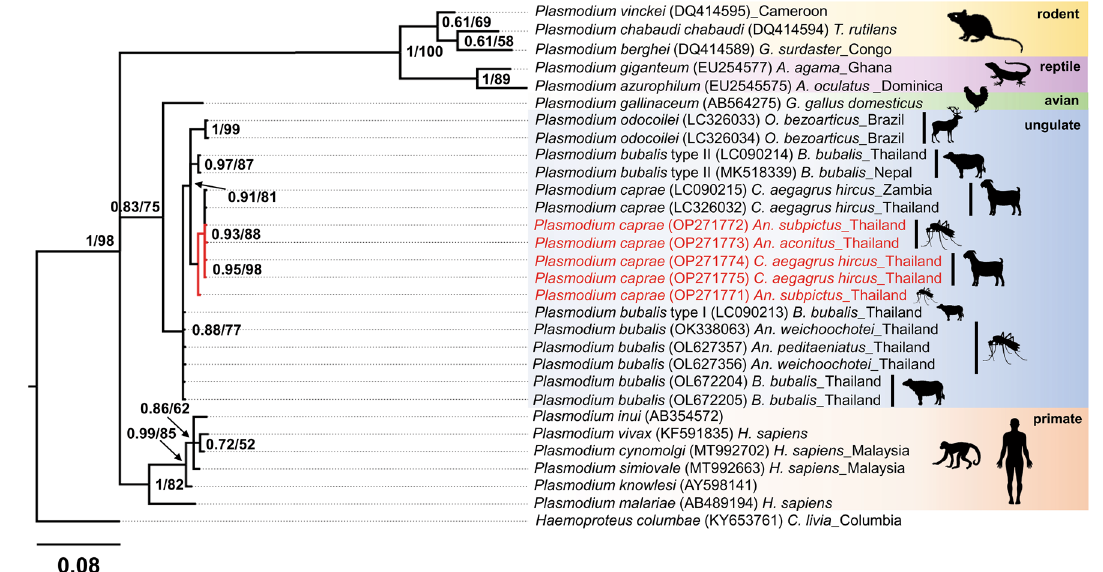
Figure 3. The phylogenetic position of P. caprae obtained in this study inferred by Bayesian inference using a partial cox1 gene (231 bp). All sequences were rooted with Haemoproteus columbae . Bayesian posterior probabilities (BPP ≥ 0.61) and bootstrap values (BV ≥ 52) are given at the nodes. The length of the substitutions/ site (0.08) is shown.